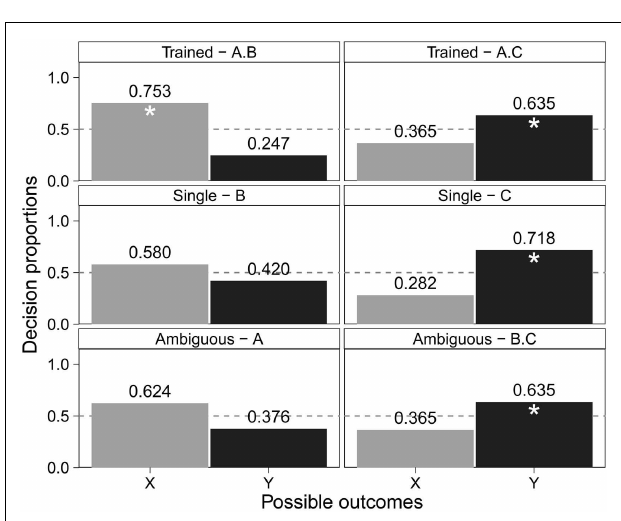
FIGURE 8 |Younger children’s data from Burling andYoshida (2011): decision proportions for possible outcomes (X,Y) given predictive cues (A, B, C) with the asterisks identifying reliably above chance ( p < 0.05).